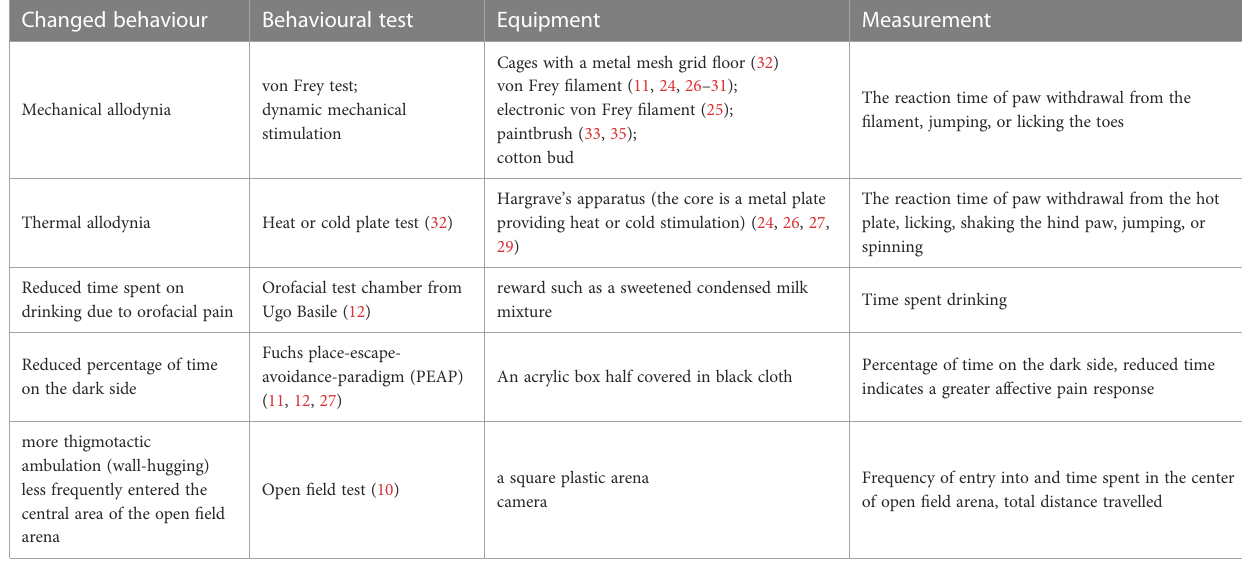
TABLE 2 Methods that applied in the characterization of current PHN rodent models. Changed